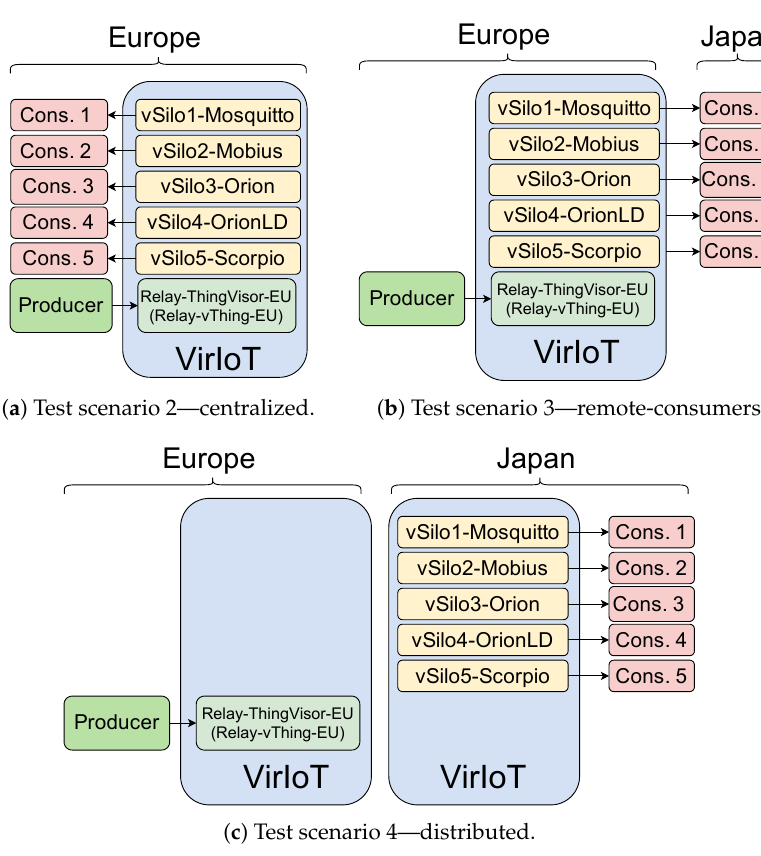
Figure 14. Test scenarios used in the comparison of IoT